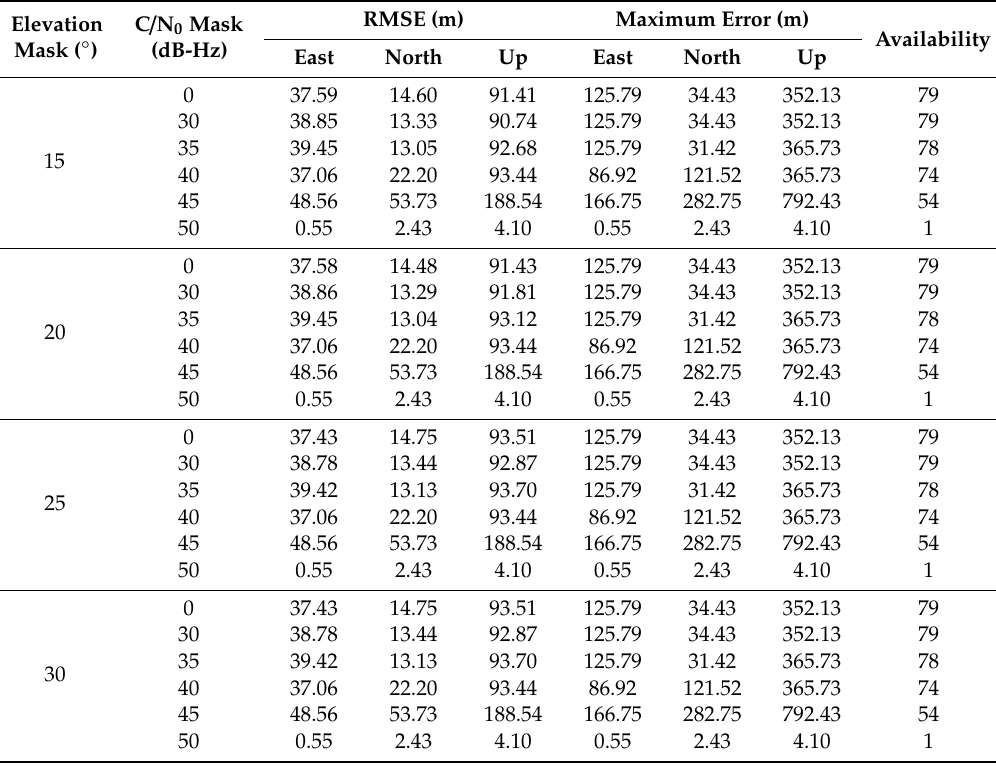
Table 7. Positioning results of D1b corresponding to di ff erent elevation angle masks and C / N 0 masks.